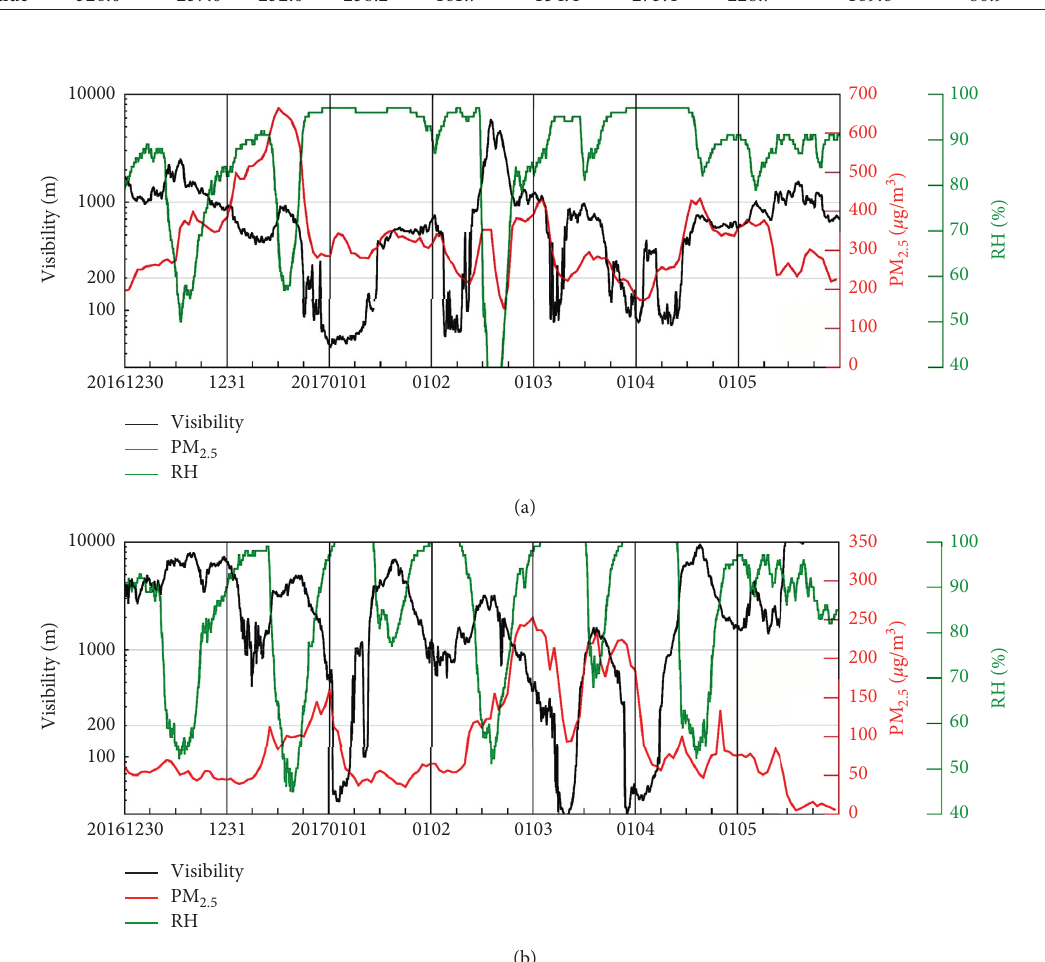
Figure 9: The variation of visibility (unit: m), PM Yancheng, Jiangsu (b), from December 30, 2016, to January 5,